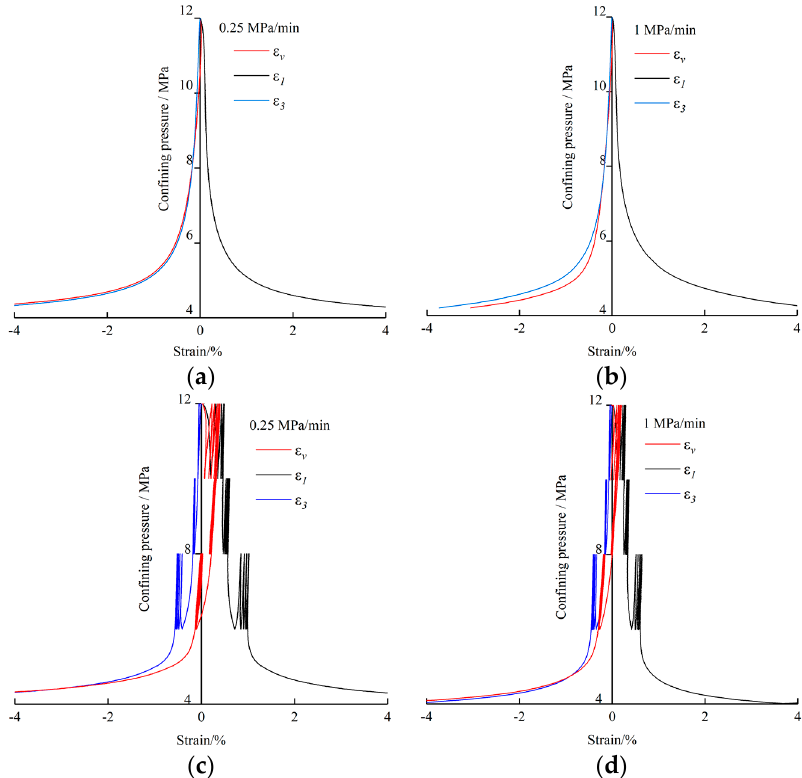
Figure 4. Stress–strain curves under different loading paths: ( a ) B-1; ( b ) B-2; ( c ) C-1; ( d ) C-2. ε 1 , ε 3 , ε V are axial strain, circumferential strain, and volumetric strain, respectively, and from here onwards. Path I: Path